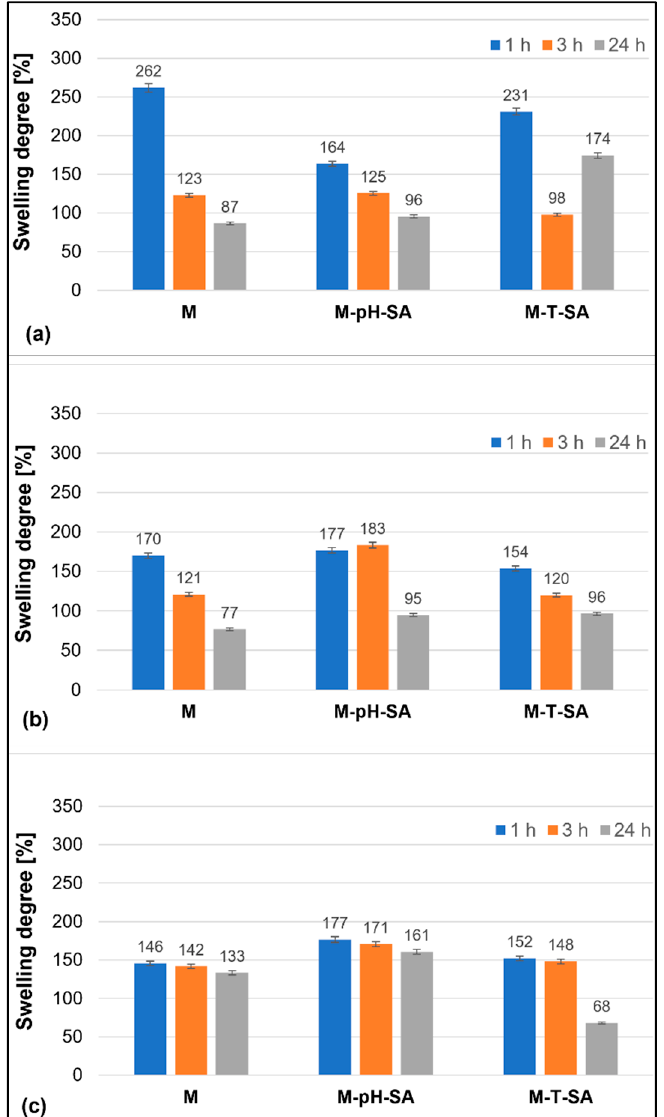
Figure 1. Swelling degree (%) of the basic matrix (M), system with pH-sensitive nanocarrier and salicylic acid (M-pH-SA), and system with thermosensitive nanocarrier and salicylic acid (M-T-SA) at 37 °C of the bio-hybrid hydrogels after tests in ( a ) distilled water; ( b ) PBS, and ( c ) SBF ( n = 3). The most favorable environment for submerging/storing the tested bio-hybrid hy- drogels is the SBF solution, in which only a slight decrease in the SR% parameter is ob- served with time. The samples containing the pH-sensitive nanocarrier–salicylic acid (M- pH-SA) system show the most stable SR% throughout the study period—the observed decrease in time does not exceed a few percent in comparison with the measurement after 1 h. Similar studies confirm that SBF fluid is a beneficial medium for preliminary bioac- tivity testing of potential biomaterials [55–57]. In the case of the M-T-SA sample, with the system of thermosensitive nanocarrier-salicylic acid, after 24 h of incubation in SBF fluid, a more than 2-fold decrease in swelling capacity and a slight matrix disintegration were observed, which is not beneficial for further applications. In contrast, immersion of mate- rials in distilled water, poorer in ions and slightly acidic, leads to a rapid uptake of water by the sample in the first hour of incubation, after which rapid expulsion of the fluid in the material is observed in every analyzed hydrogel. On the other hand, in phosphate- buffered saline, the most favorable swelling parameters are achieved by M-T-SA bio-hy- brid hydrogels, where a gradual decrease in the SR% parameter over time is observed.